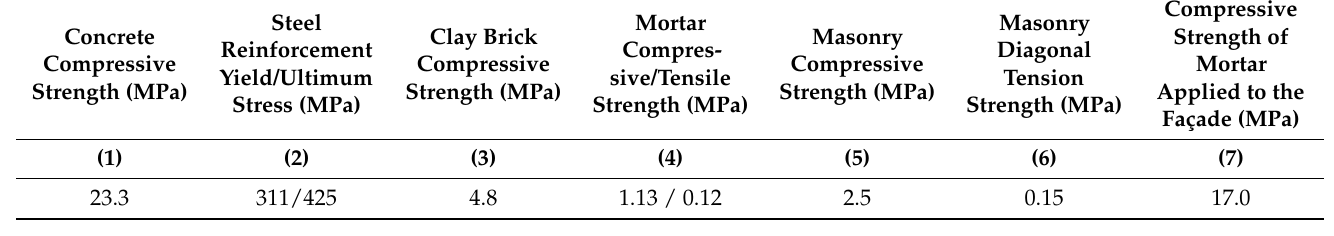
Table 1. Basic mechanical properties of all the building materials [23].